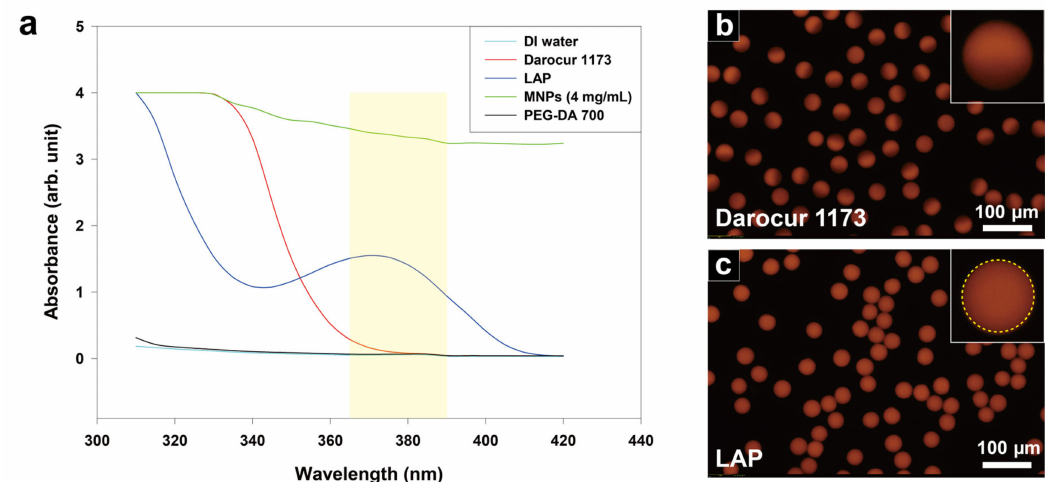
Figure 2. E ff ect of photoinitiator absorbance on magnetic hydrogel polymerization. ( a ) Absorbance spectra of components used in dispersed phase fluid. The wavelength band of irradiated light is shaded in yellow. ( b ) Fluorescence image of magnetic hydrogels polymerized with Darocur 1173. ( c ) Fluorescence image of magnetic hydrogels polymerized with